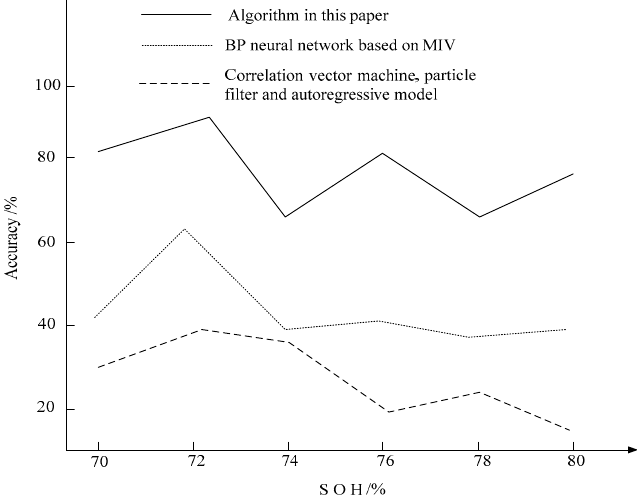
Figure 7. The comparison of the life prediction accuracy of three algorithms between 70% and 80% SOH.